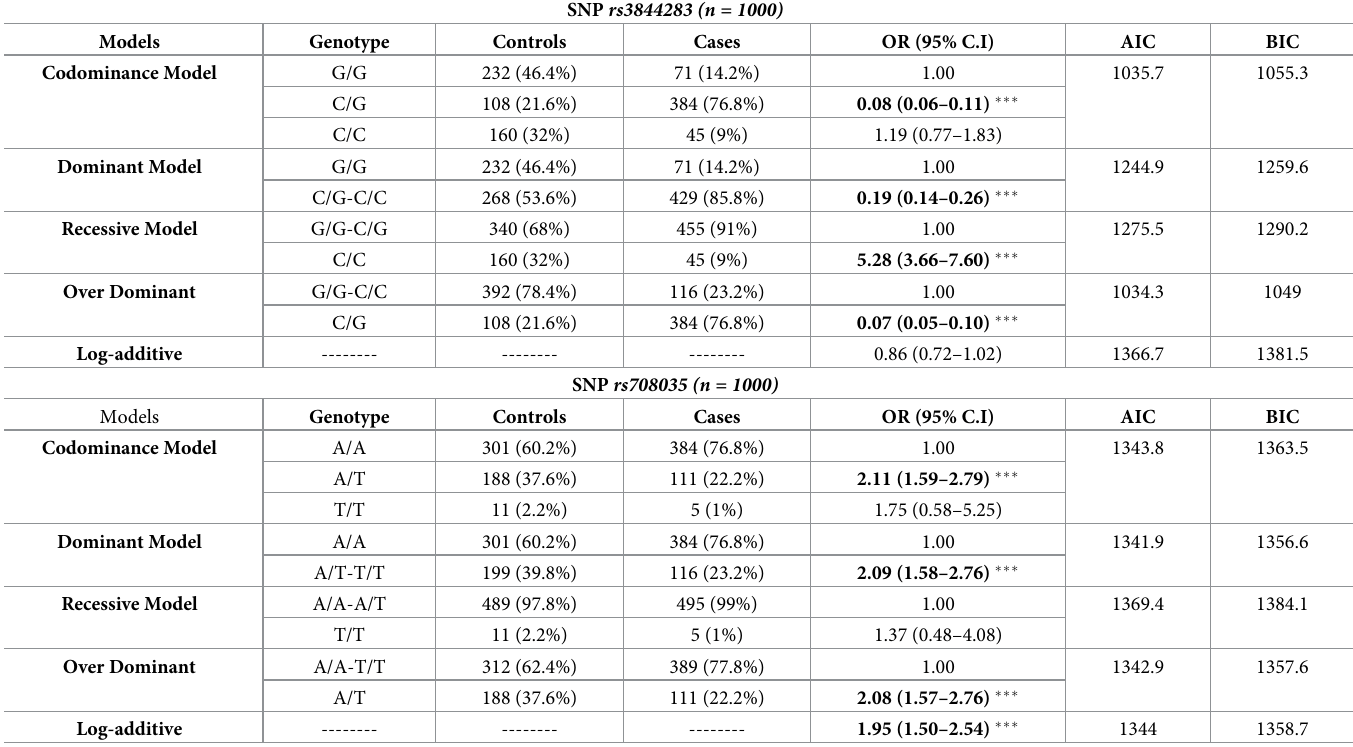
Table 3. Genetic model-based analyses of SNPs rs3844283 and rs708035 among